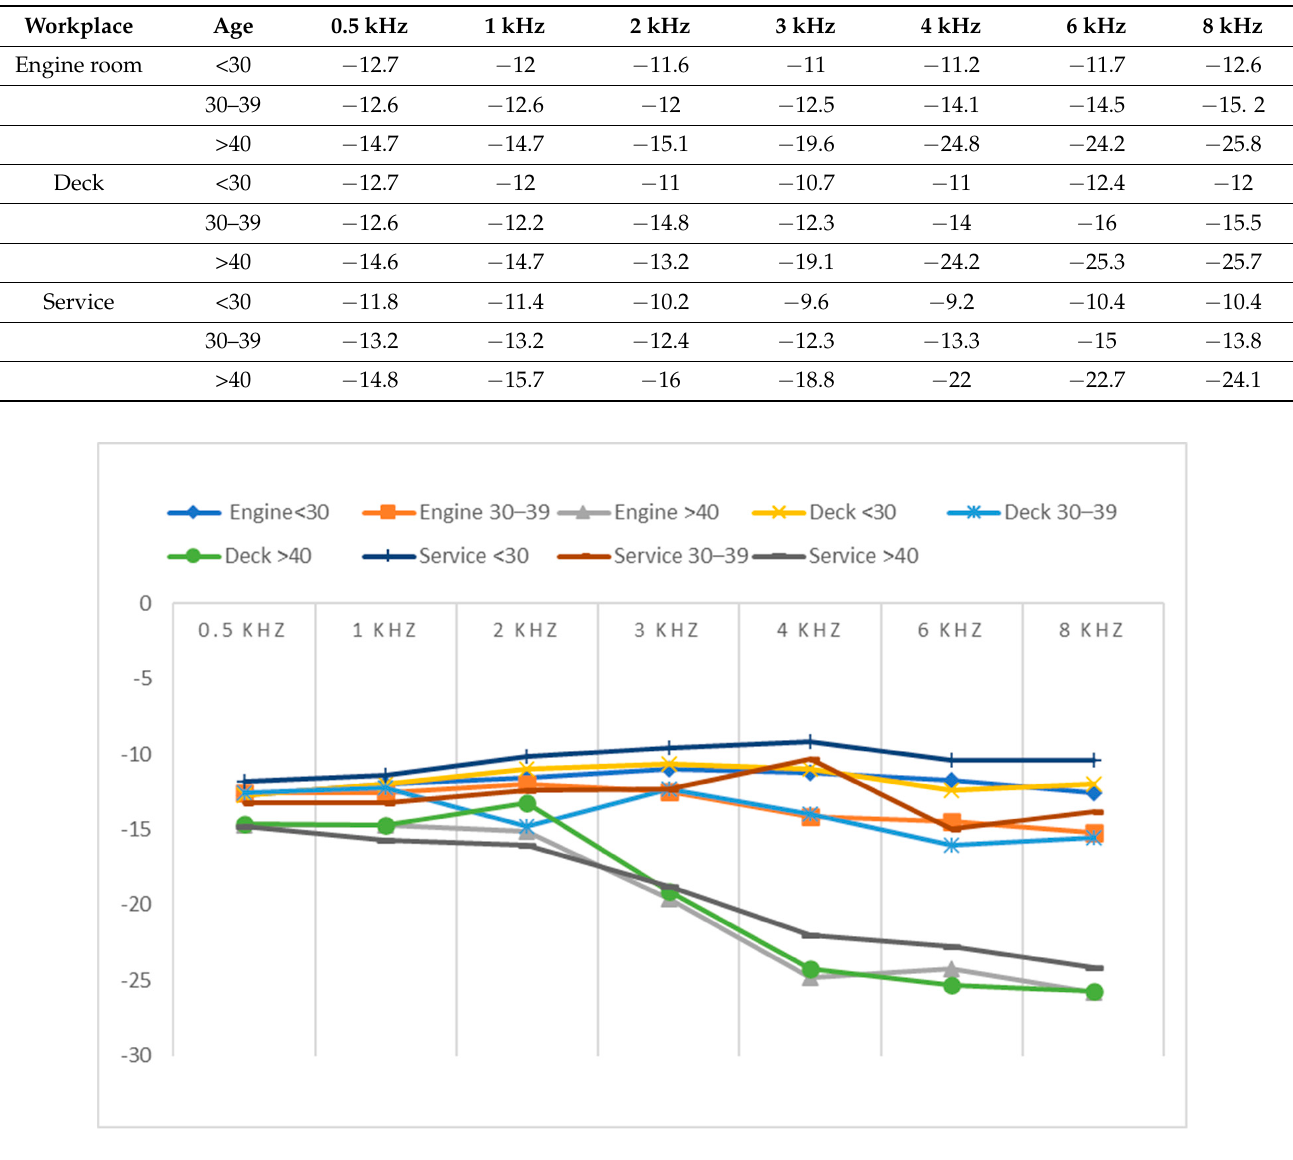
Table 3. Mean hearing threshold levels in the sample of merchant seafarers, in each frequency tested.